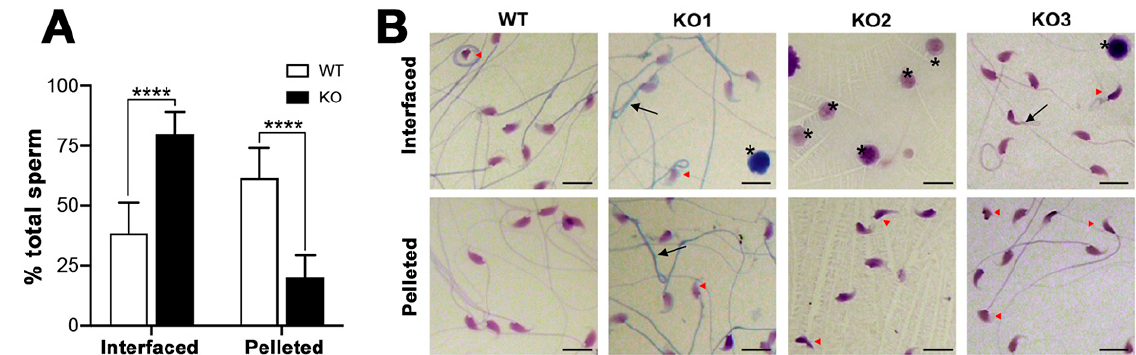
Figure 11. An increase in sperm with abnormal morphology in Arsa KO mice, 8 months of age, as compared with age- matched WT sperm. Caudal epididymal sperm from Arsa KO and WT mice were separately subjected to Percoll gradient (35/70%) centrifugation. ( A) Distribution of WT and Arsa KO sperm interfaced between the two Percoll solutions and those pelleted after Percoll gradient centrifugation. Results were expressed as means ± SDs of total sperm from 7 each of WT or Arsa KO sperm preparations, performed in parallel. Sperm (and immature germ cells) retrieved from 2–4 WT or 4–8 Arsa KO mice were used in each Percoll gradient centrifugation. **** denotes p < 0.0001. ( B ) Select morphological images of sperm sedimented as the pellet or at the Percoll gradient interface. Images from only 1 WT sample were shown as the results were very consistent throughout all WT samples. Images of pelleted and interfaced sperm in three preparations (KO1, KO2 and KO3) from Arsa KO mice were shown in comparison. Red arrow heads and black arrows denote abnormality in sperm heads and tails, respectively. Stars indicate the presence of immature germ at the gradient interface cells in the KO